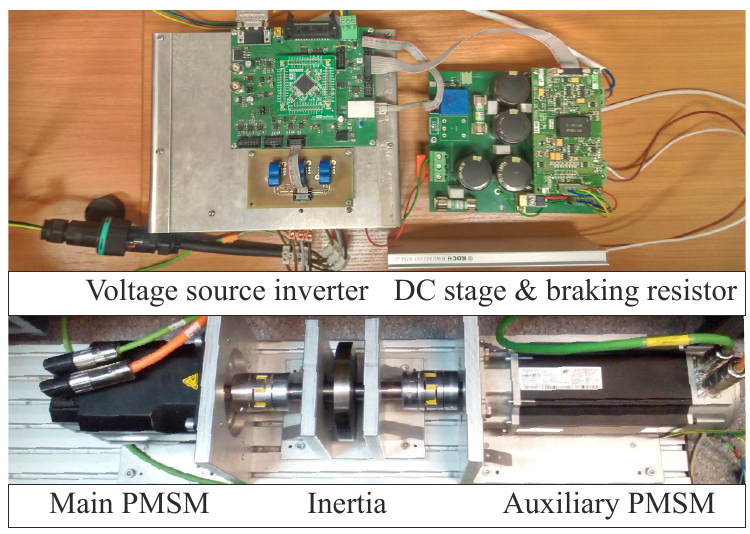
Figure 2. Photo of laboratory stand. Table 2. Parameters of the